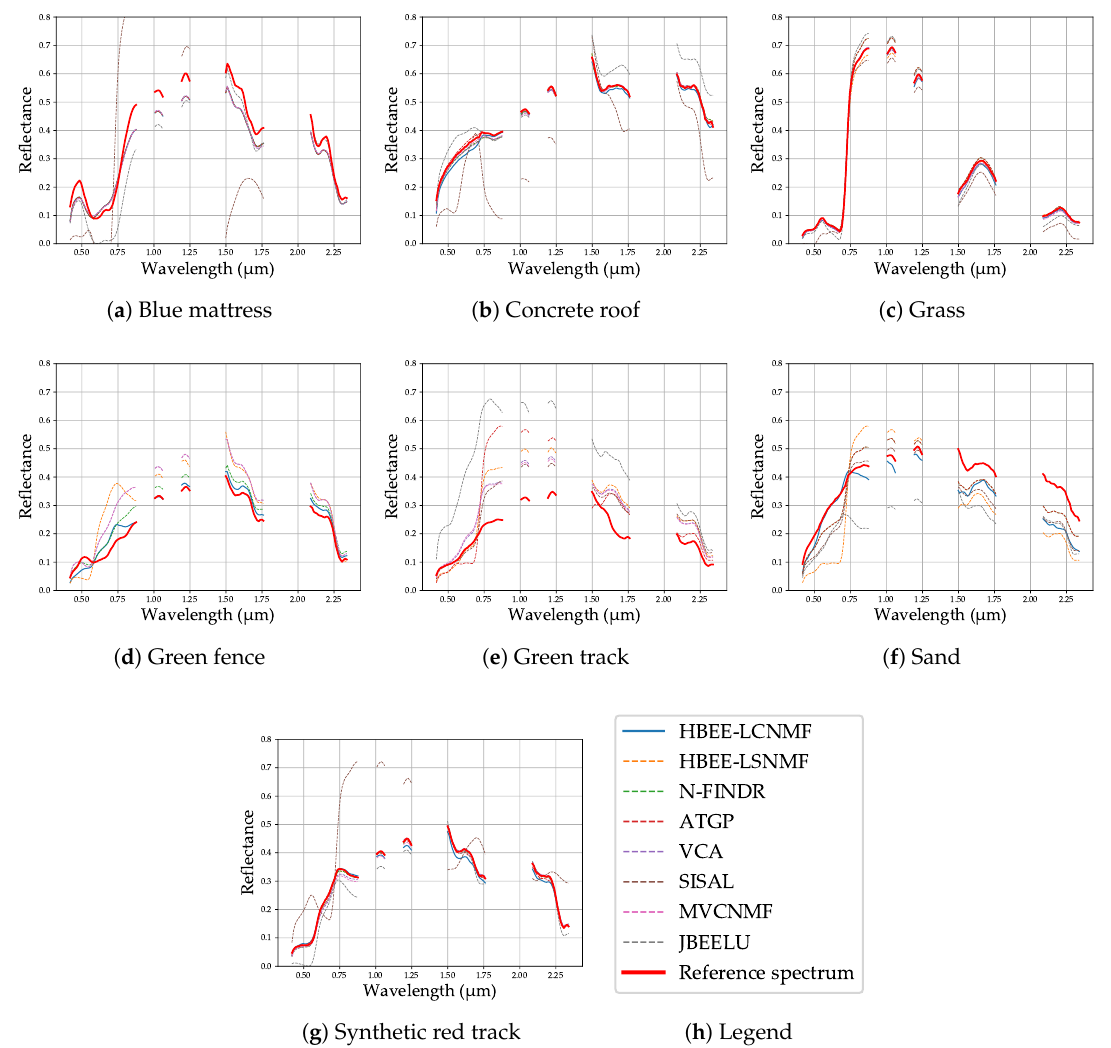
Figure 13. Estimated endmembers compared to their corresponding references for the Basel data set. The SAM criterion is used to match the estimated endmembers with the reference